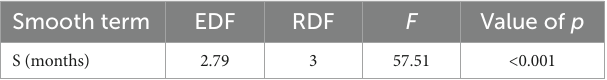
TABLE 4 The generalized additive mixed model (GAMM) represents the strong non-linearity of cutaneous leishmaniasis in different provinces of Iran,